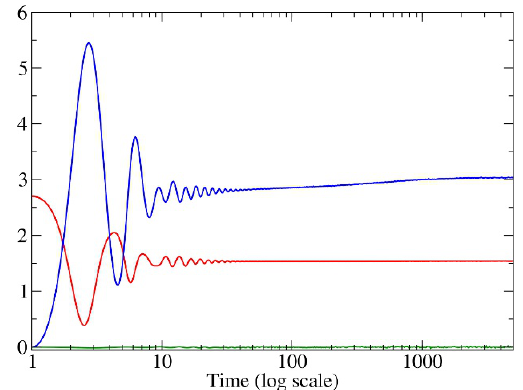
Figure 1 . From top (red) to bottom (blue), expectation values of O (6) with N = 15 and vol( E ) (cid:25) 10 3 . In the log coordinate t = log s , the approach to the equilibrium is hOi ( t ) (cid:0) O 1 = d=s (cid:28) with d > 0 for O (6)